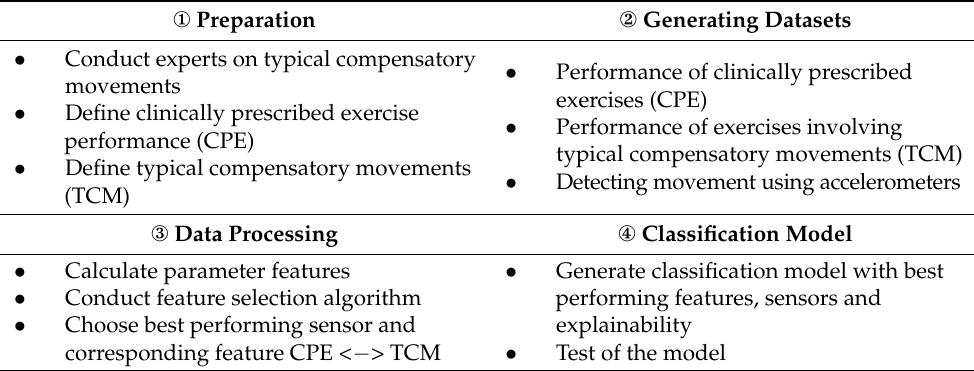
Table 1. Overview of the process describing the subtasks of Generating Datasets, Data processing and Classification